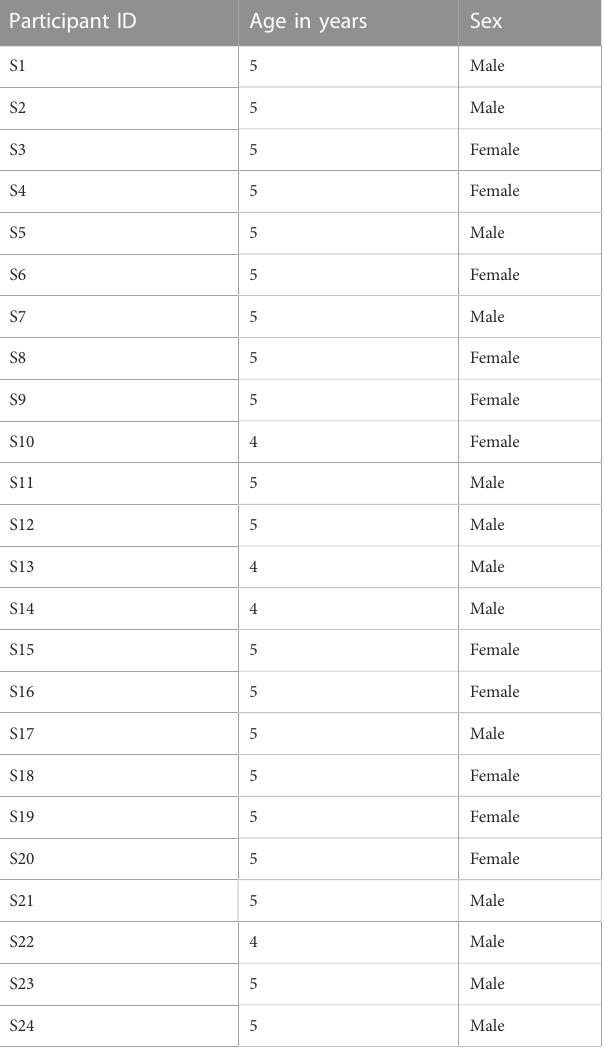
TABLE 1 Age and sex of the